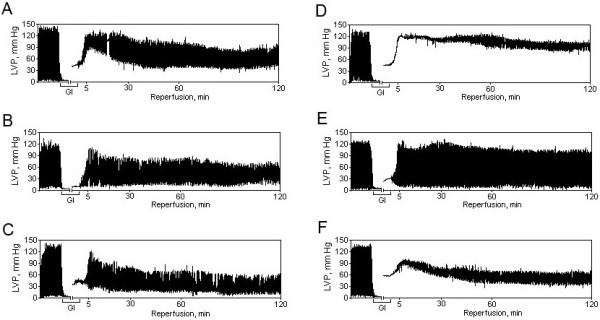
Representative LV pressure recordings demonstrating different patterns of LV function recovery in CON-22 (A), mKHB-22 (B), STH2-22 (C), CON-37 (D), mKHB-37 (E), and STH2-37 (F) groups. See Figure 1 for the group legends. GI, global ischemia; LVP, left ventricular pressure.